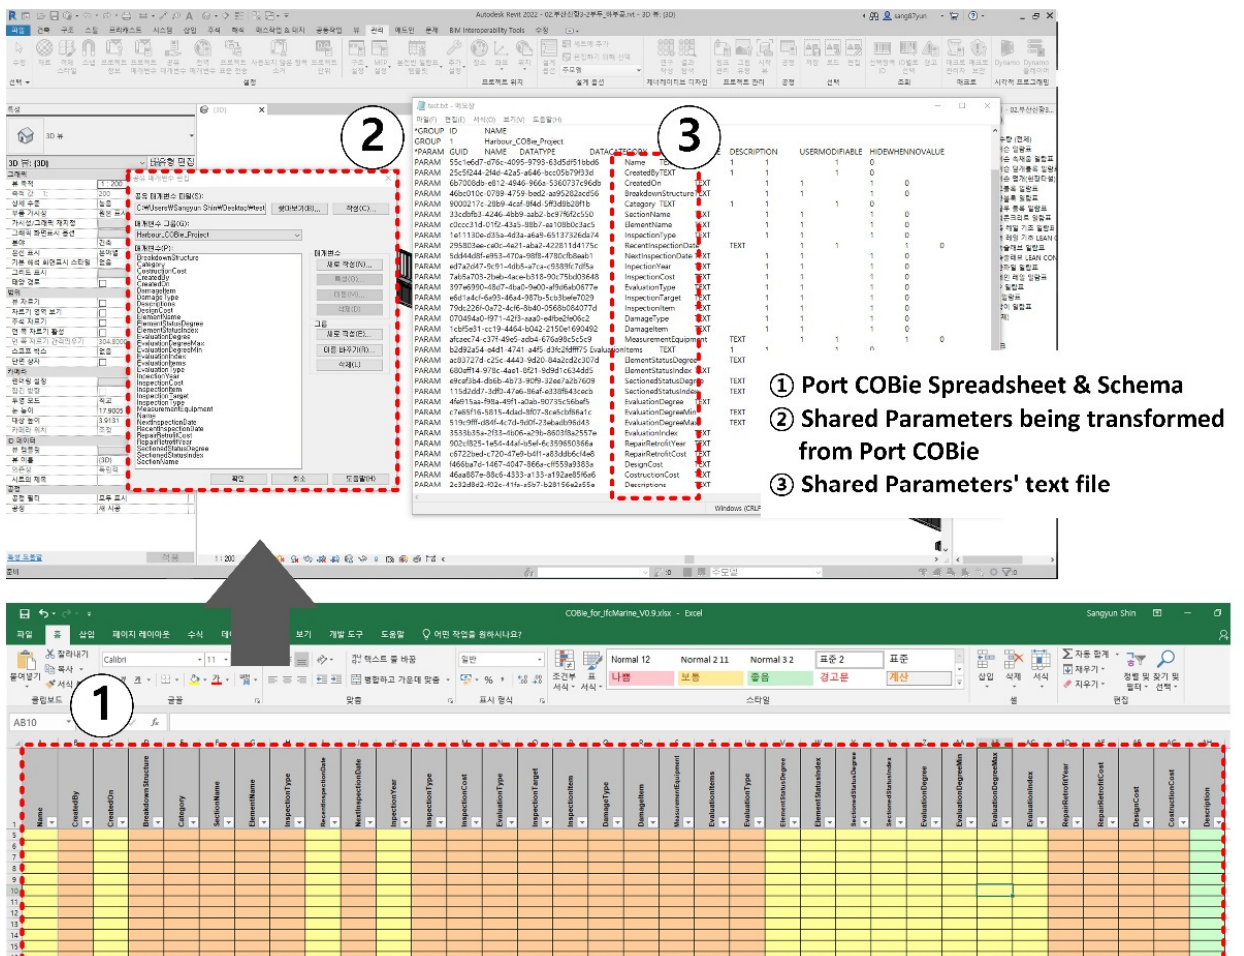
Figure 14. For creating shared parameters based on the port COBie for implementing port COBie input system.